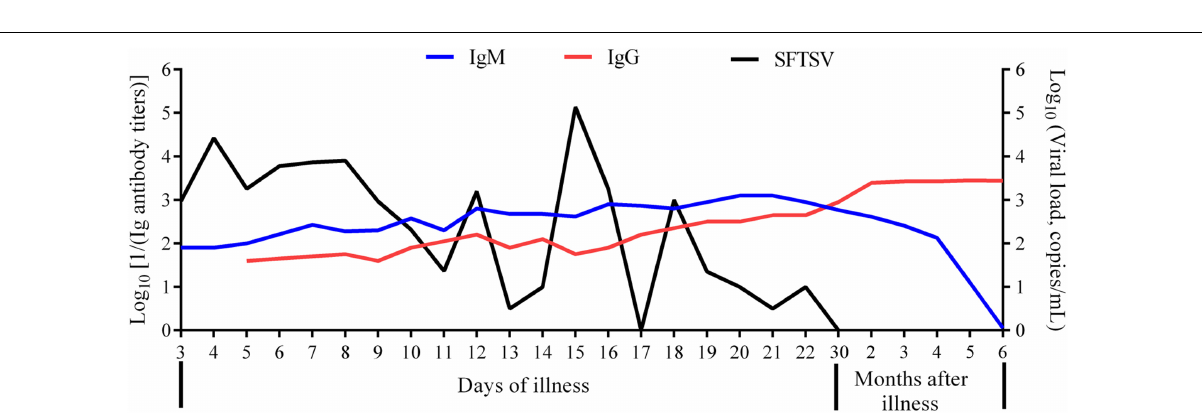
Frontiers in Microbiology |